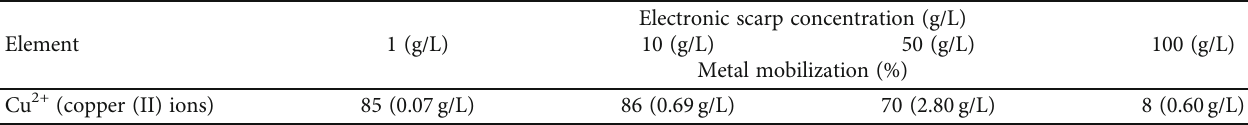
Table 2: Electronic scrap concentration and metal mobilization of e-waste leachates at di ff erent concentrations using A. niger for the biotechnology treatment of Cu (II) ions contained in solid waste [27,